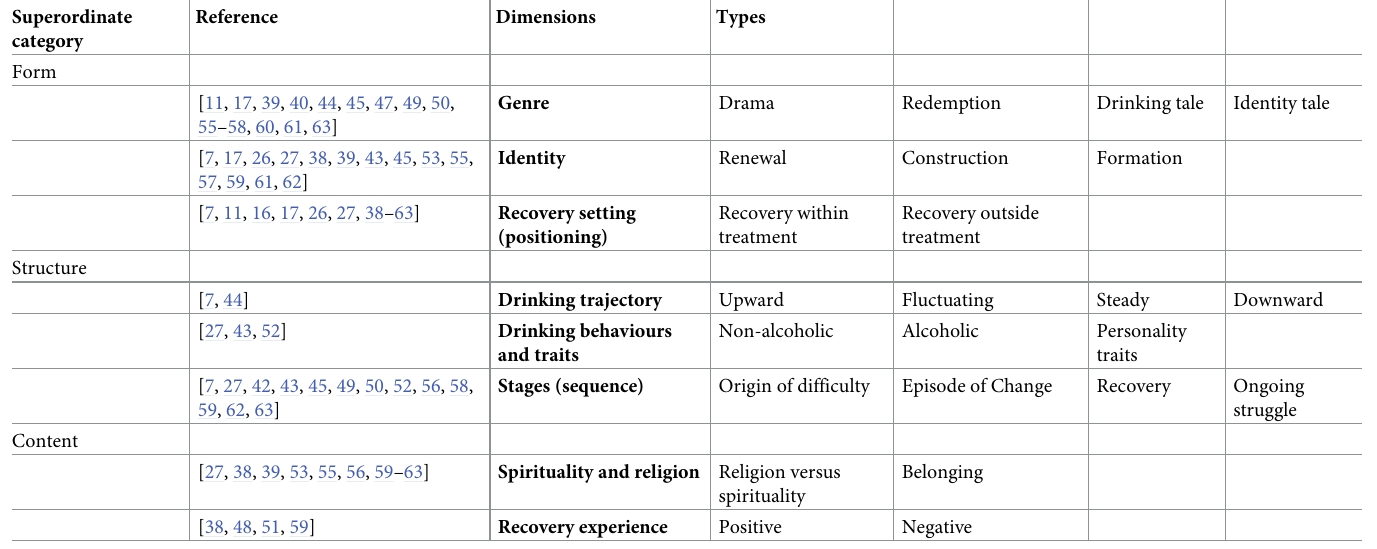
Table 2. Dimensions of alcohol recovery